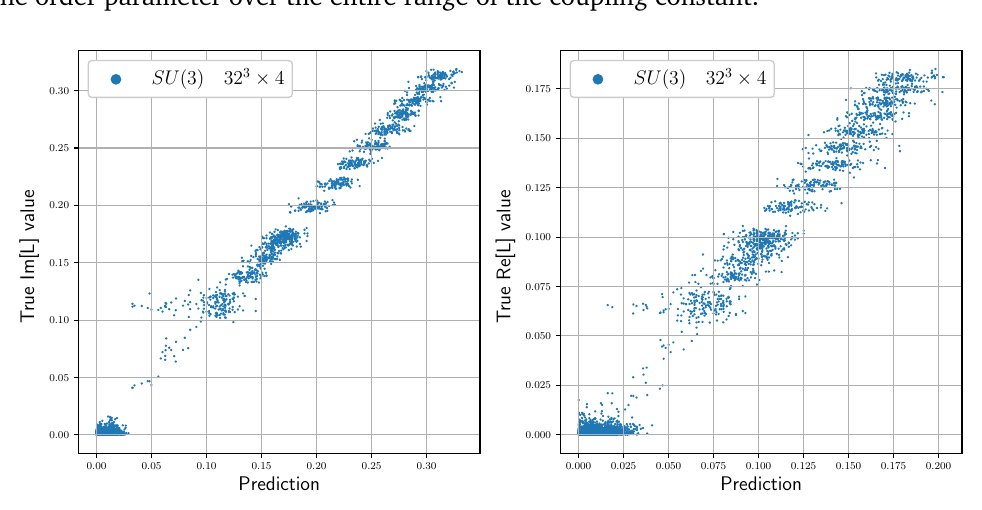
Figure 1: Prediction of neural network on a sample by sample basis of SU(3) 32 3 × 4 configurations, where β values were used in the range from 4 to 7 with a step of